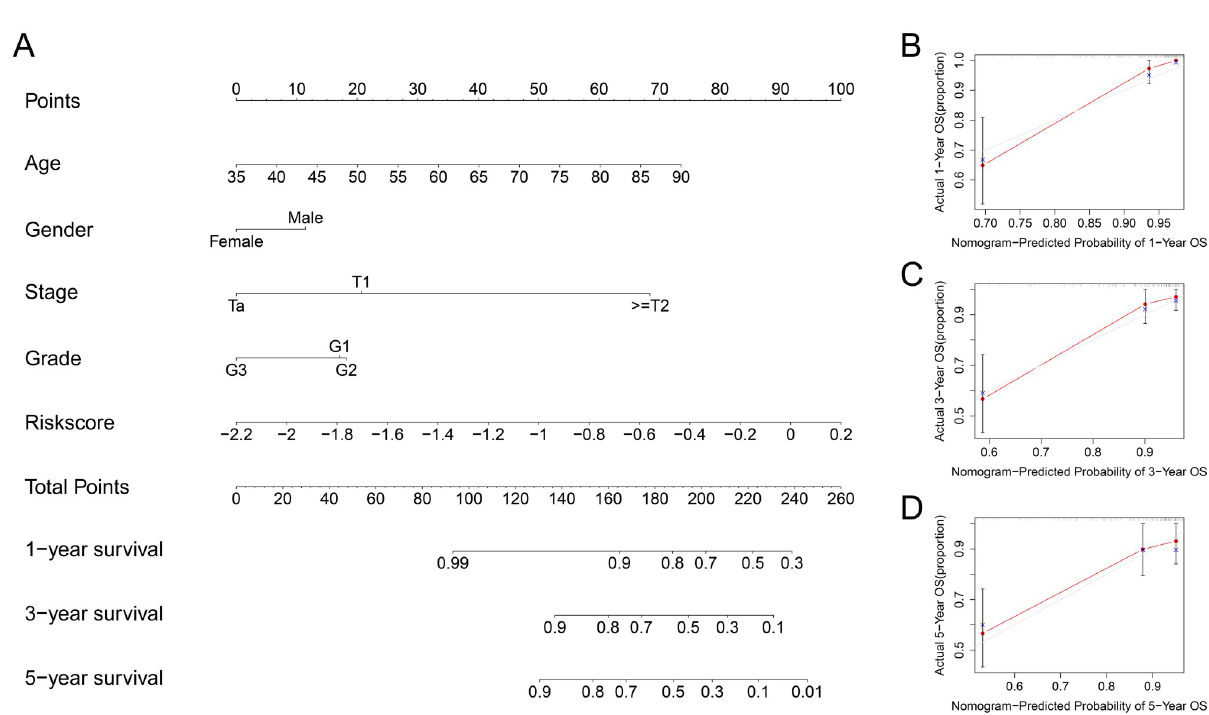
Fig 5. Establishment of the nomogram in GEO. The results of the nomogram (A) and the calibration curve appropriately predicted 1-year (B), 3-year (C) and 5-year (D) OS for BC patients in GEO. GEO, Gene Expression Omnibus; OS, overall survival; BC, bladder cancer.